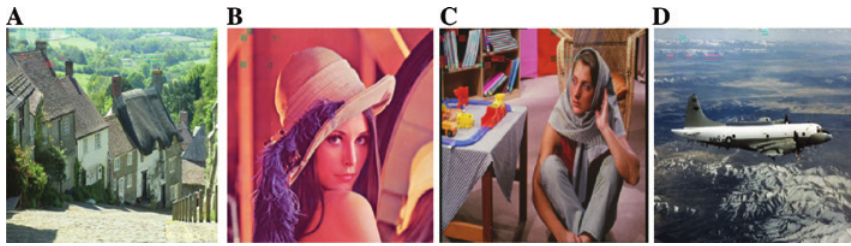
Figure 5: STs After Embedding the Cameraman Image: (A) Goldhill, (B) Lena, (C) Barbara, (D)